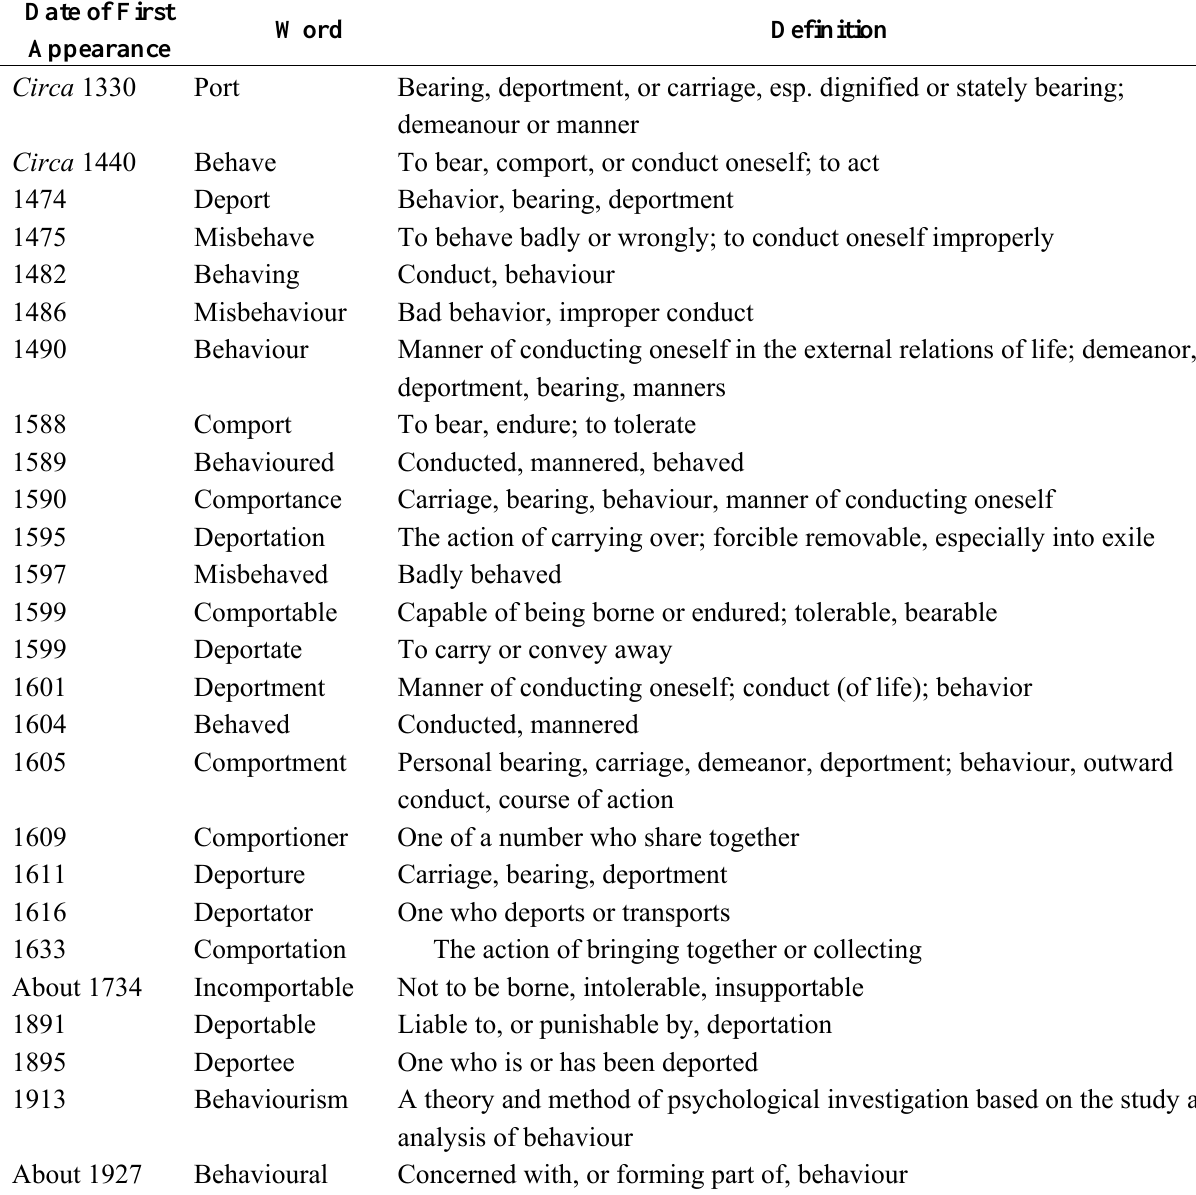
Table 2. Behavior words, defined and listed